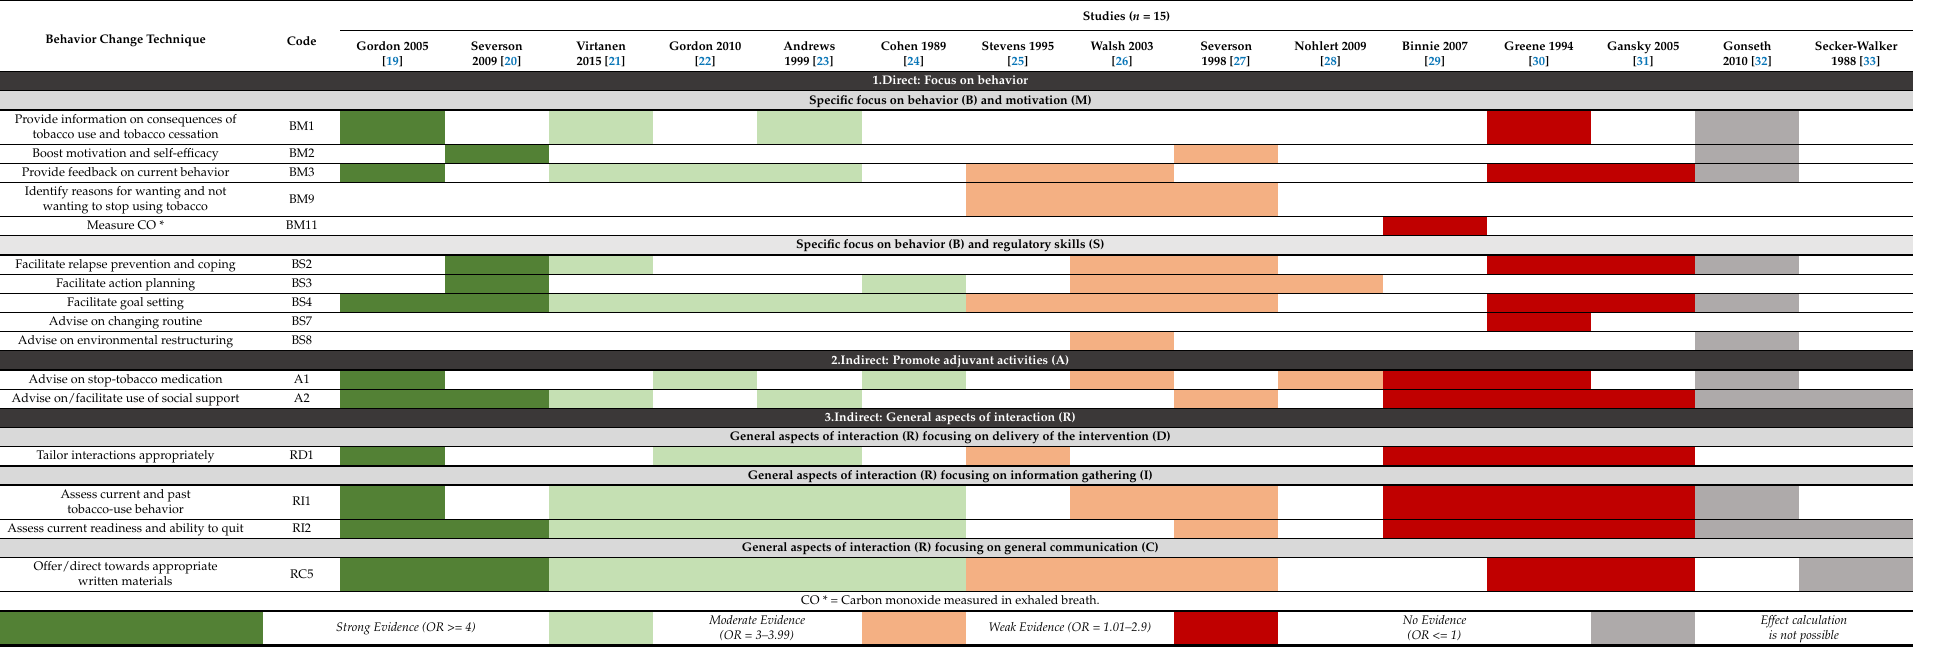
Table 2. Behavior change techniques for tobacco cessation interventions in dental practice and its relation to intervention